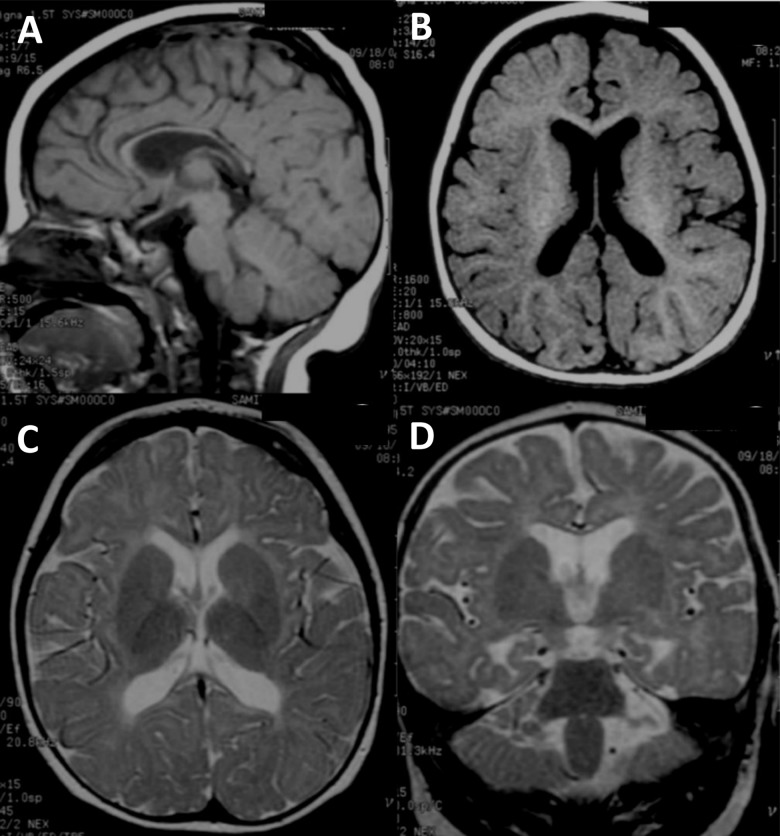
Brain MRI image of the ASD proband. (A–D) Brain MRI of the ASD proband at 10 months of age (II-2). (A) T1-weighted sagittal image shows fully formed but diffusely thin corpus callosum. The cerebellar vermis is normal. (B) T1-weighted axial image reveals normal gyral pattern of cerebral cortex and diminished cerebral white matter volume. (C) T2-weighted axial image demonstrates delayed myelination at anterior limbs of both internal capsules and diffuse white matter abnormalities seen as T2W hyperintensity at periventricular and subcortical white matter. (D) T2-weighted coronal image shows more obvious mild cerebral atrophy seen as enlarged CSF space and prominent temporal horns of both lateral ventricles. Diffuse white matter abnormalities at periventricular and subcortical white matter are noted.